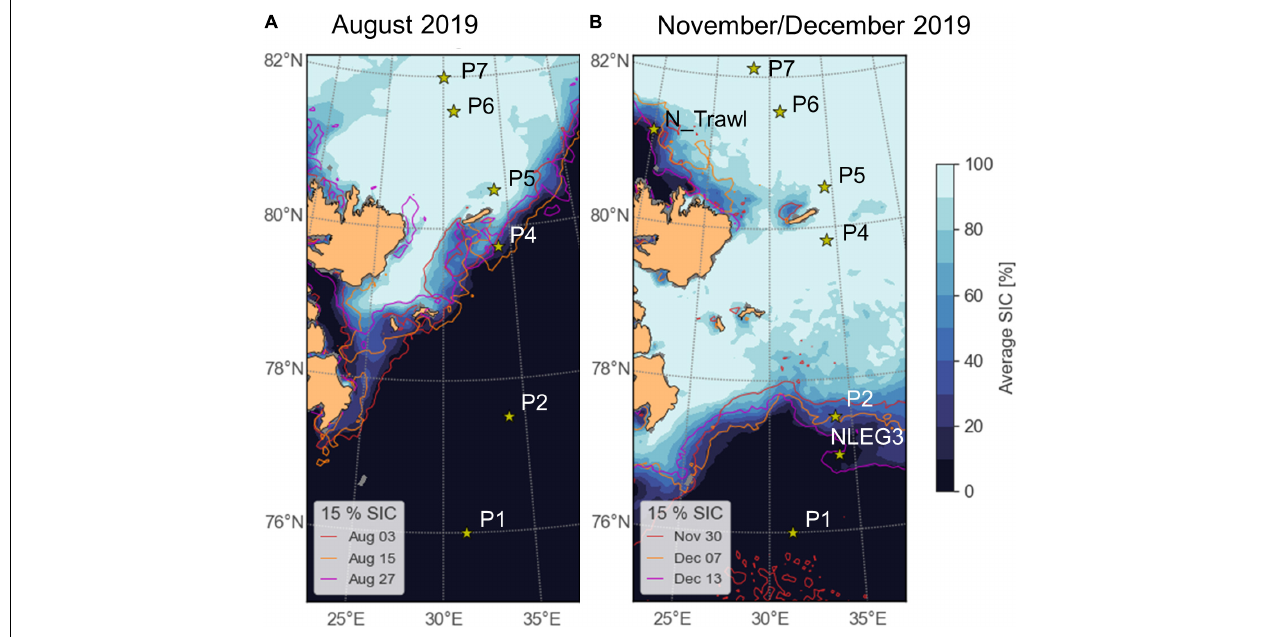
FIGURE 1 | Sampling area with sampling stations during Nansen Legacy cruises (A) Q3 (polar day, August 2019) and (B) Q4 (polar night, November/December 2019). Sea-ice concentrations ( SIC %) are shown for the beginning, mid and end of sampling for each sampling campaign, respectively. SIC data acquired